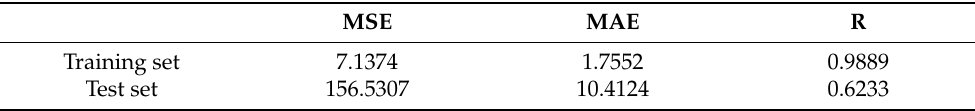
Figure 7. BR-ANN model fitting.